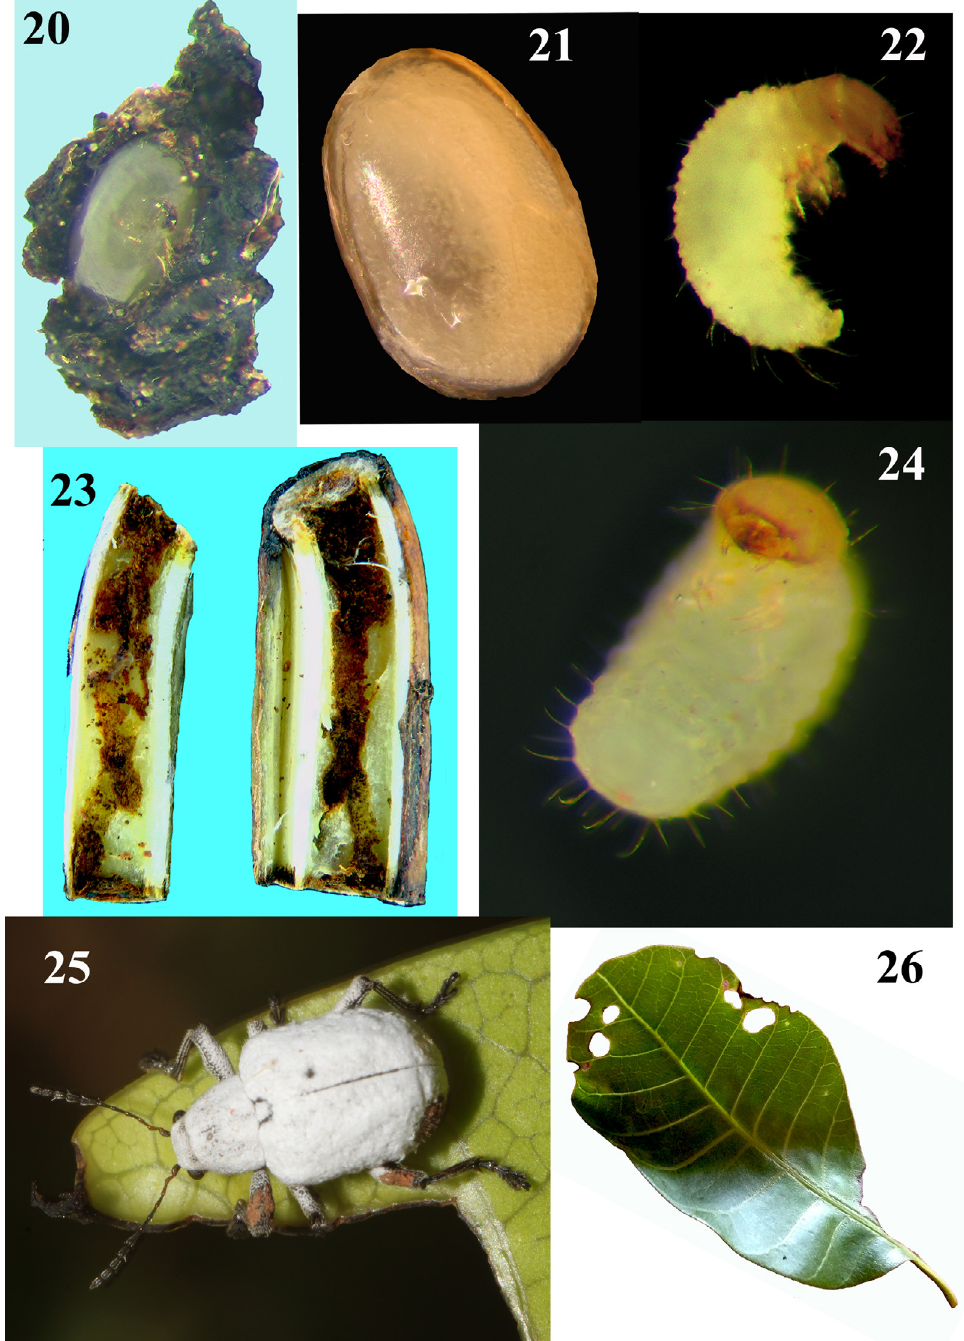
Figs 20–26. Biology and ecology of Fidia kanaraensis (Jacoby, 1895) comb. nov. 20 . Eggs covered with excreta. 21 . Naked eggs. 22 . First instar grub, lateral view. 24 . First instar grub, ventral view. 23 . Damage on mango root. 25 . Adult beetle on mango leaves. 26 . Damage on cashew